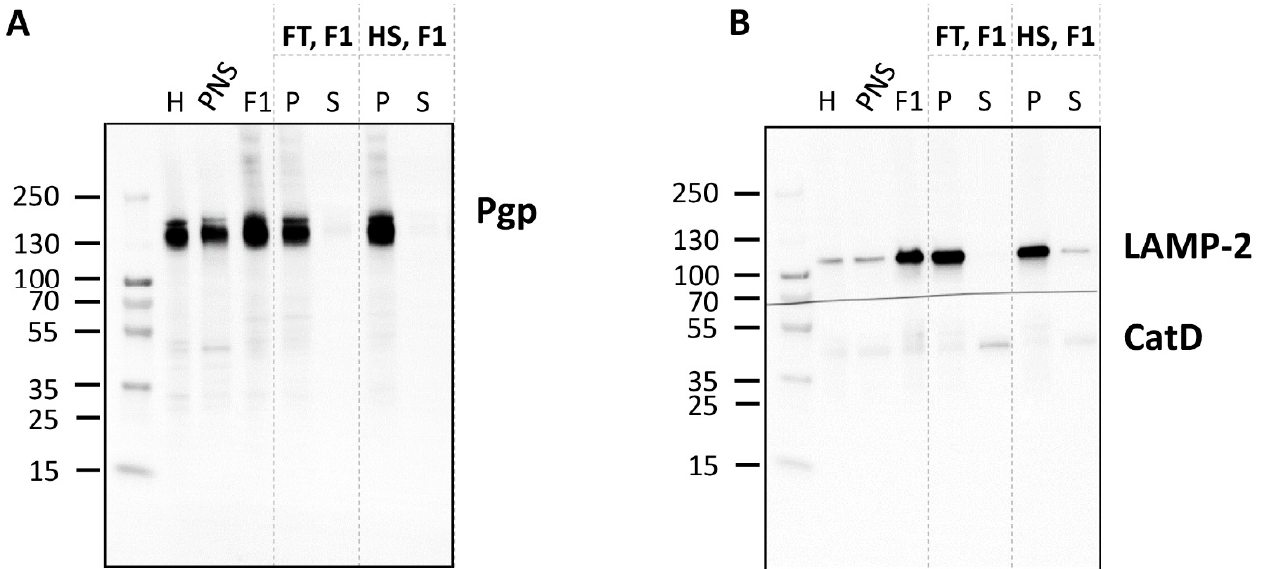
Figure 4. Detection of Pgp in the membrane fraction of F1. The endolysosome-enriched fraction was separated into soluble (luminal) and membrane subcompartments and analyzed by Western blotting for Pgp localization ( A ). The organelle membranes were ruptured applying two different methods in comparison, either repeated freeze–thaw (FT) cycles or a hypoosmotic shock (HS). The pellet (P) enriched in membrane proteins and the supernatant (S) containing soluble luminal proteins were analyzed by Western blotting (5 µg total protein/lane of P and corresponding amount of S). Liver homogenate (H), post-nuclear supernatant (PNS), and fraction 1 (F1) (5 µg total protein each) were analyzed for comparison. ( B ) LAMP-2 was used as a marker protein for the membrane fraction, whereas cathepsin D (CatD) served as a control protein for the soluble endolysosomal protein frac- tion.